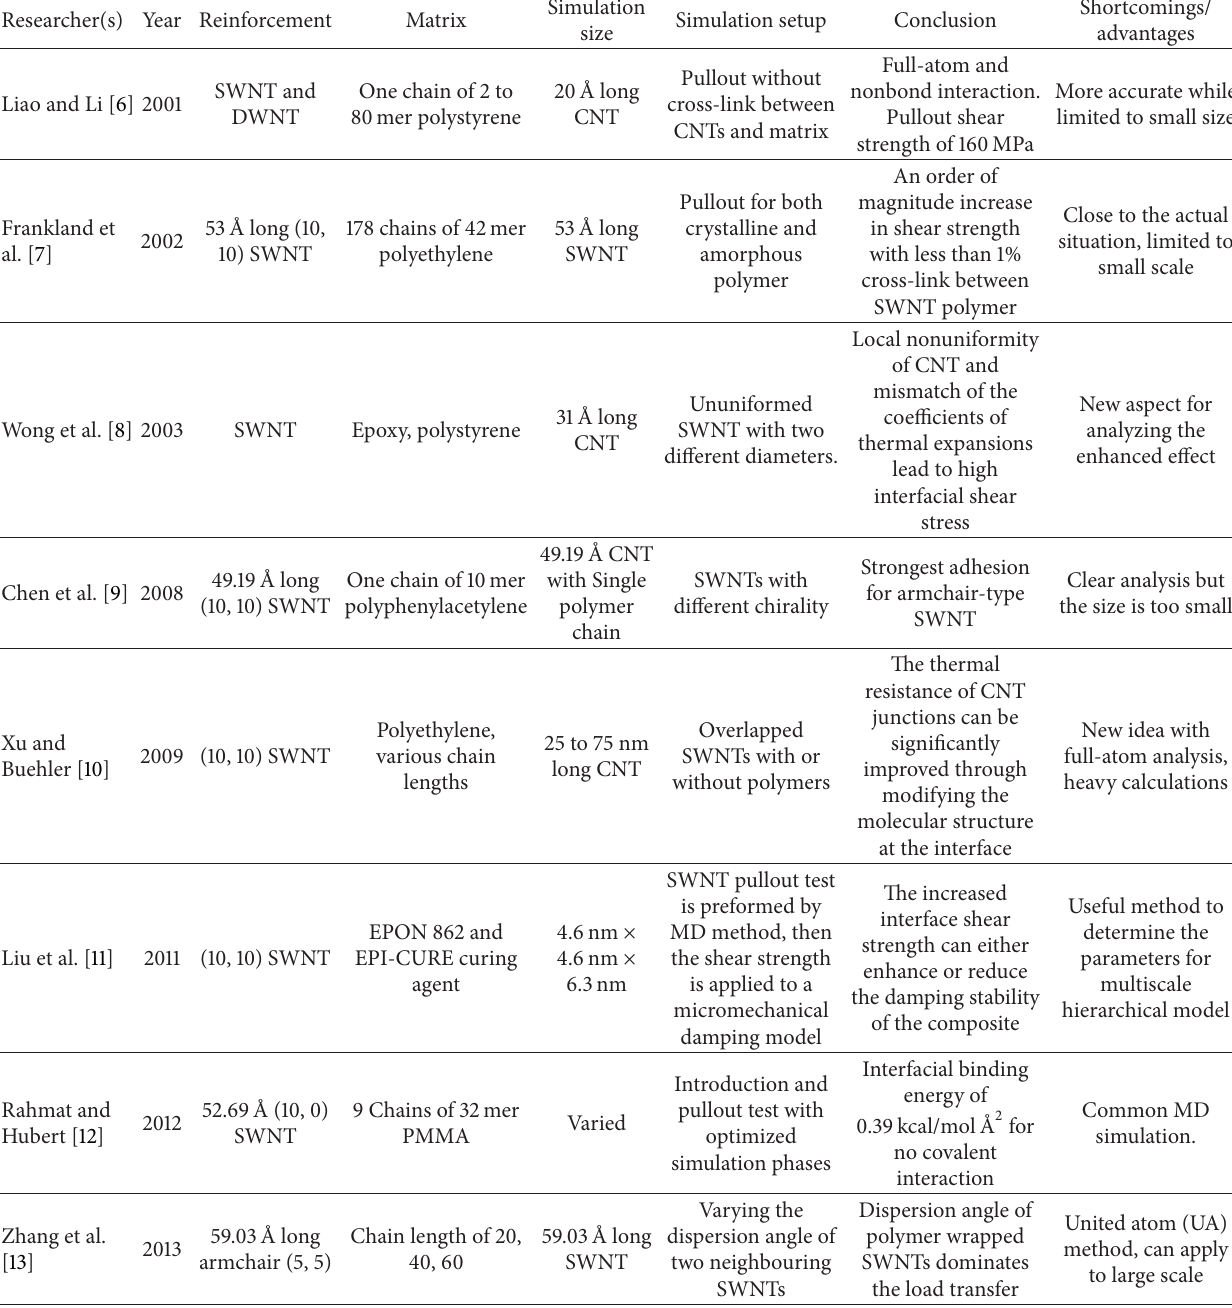
Table 1: Conducted molecular dynamics modeling of interaction between the CNT and the